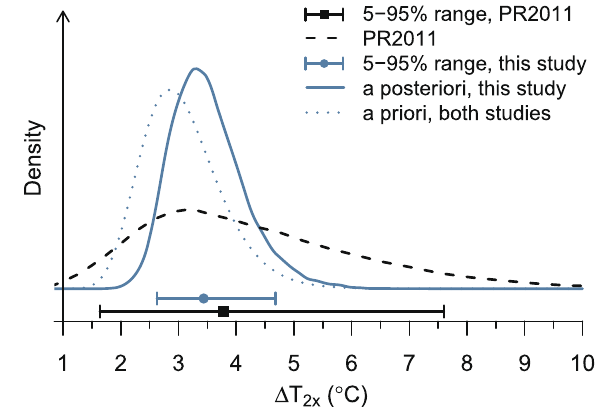
Fig. 2 A posteriori probability density for Earth-system sensitivity parameter ( Δ T 2 x , solid blue line). The posterior density is plotted relative to the prior density (dotted line) and the results from Park and Royer 14 (PR2011, dashed black line). At bottom, the points provide median estimates from this study (blue circle) and from Park and Royer 14 (black square) and whiskers denote the 5 – 95% probability